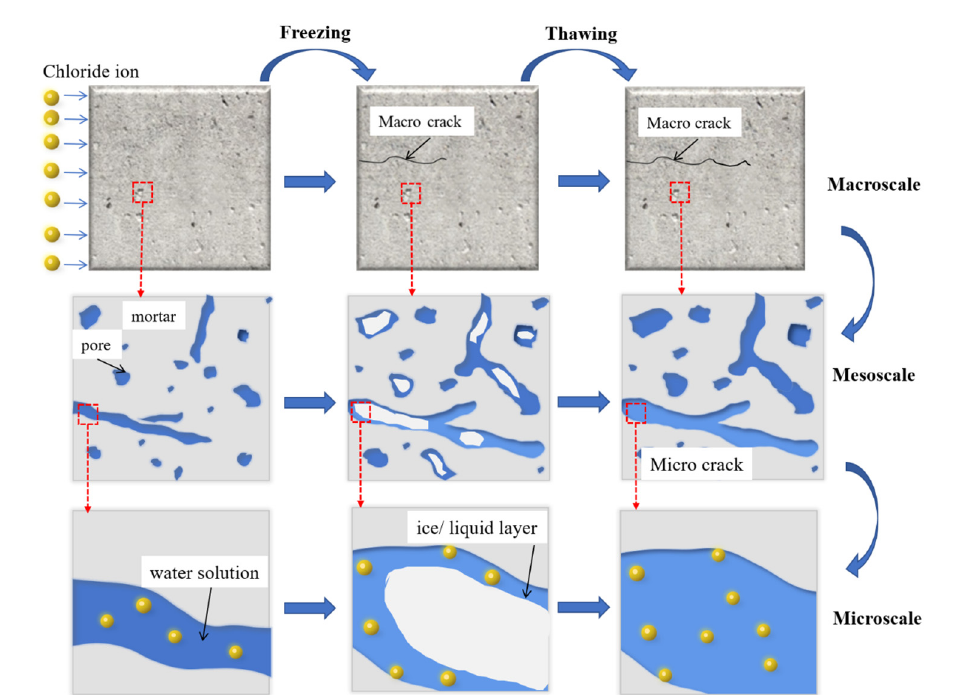
Figure 8. Schematic diagram of concrete damaged the dual attack of freeze ‐ thaw cycles and chloride ingress. Adapted from [70,